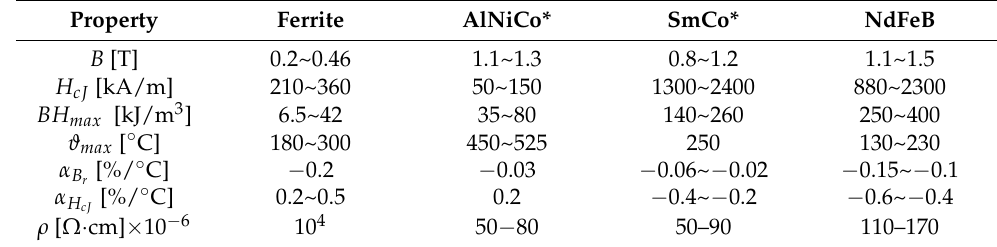
Table 1. Typical physical properties of common PM materials [12].